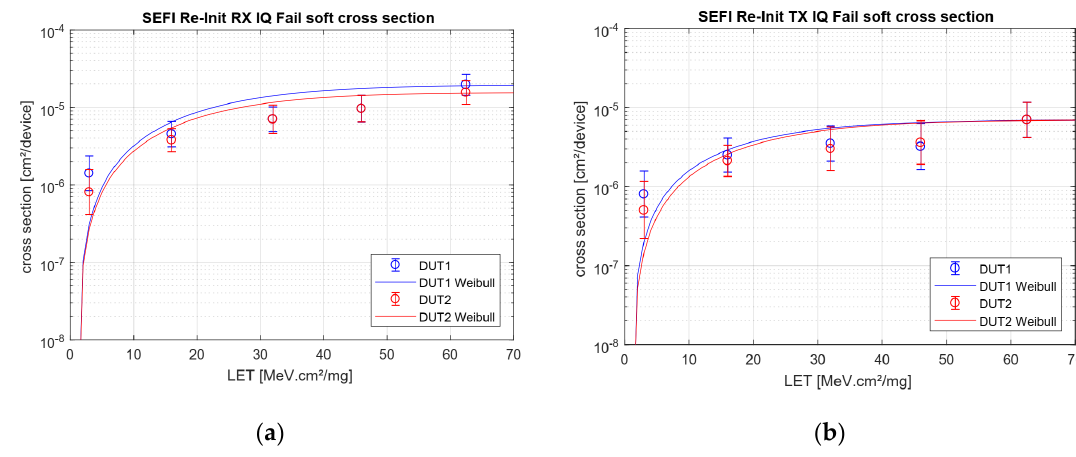
Figure 12. SEFI cross sections for re-initialization events based on ( a ) soft IQ failures on the receiver chain and ( b ) soft IQ failures on the transmitter chain (W = 30.50, S = 1.809).